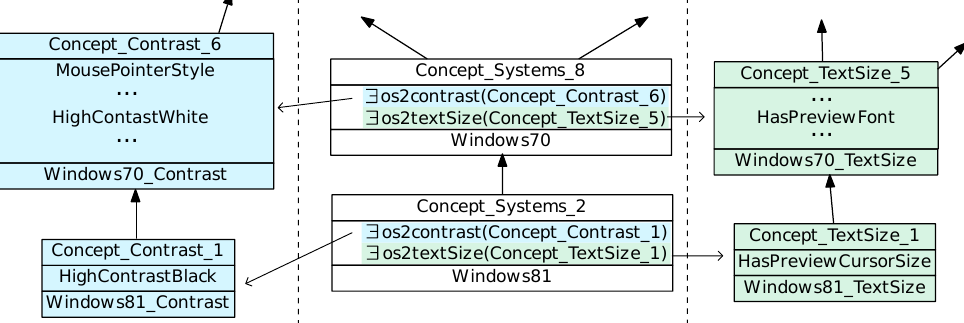
Figure 11. Excerpt of several concept lattices (redrawn from the lattices output of the tool for the sake of explainability) to illustrate co-occurrences and implications in the central